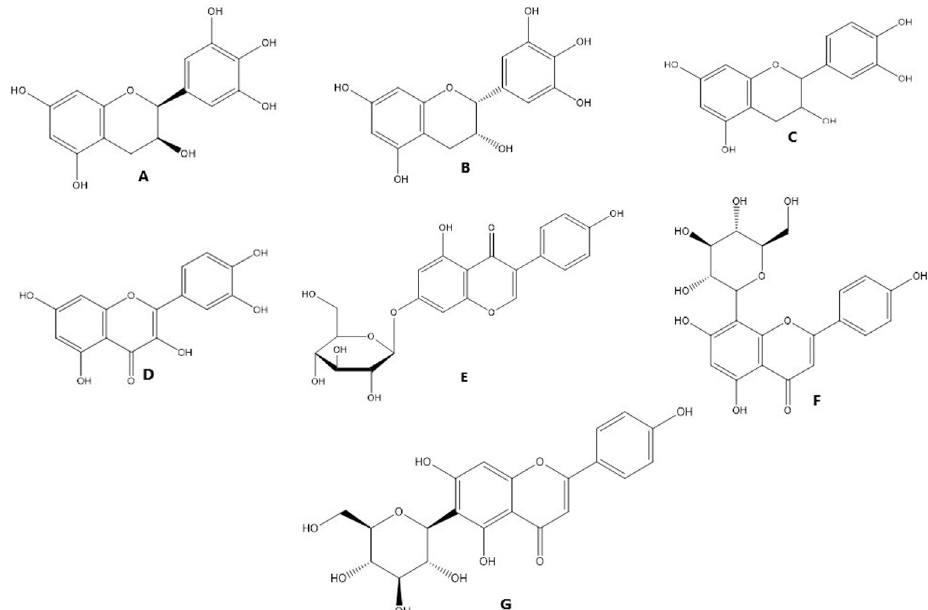
Figure 6. Some compounds responsible for the F. deltoidea biological activity. A. Gallocatechin; B. epigallocatechin; C. catechin; D. quercetin; E. Genistin; F. vitexin; G.